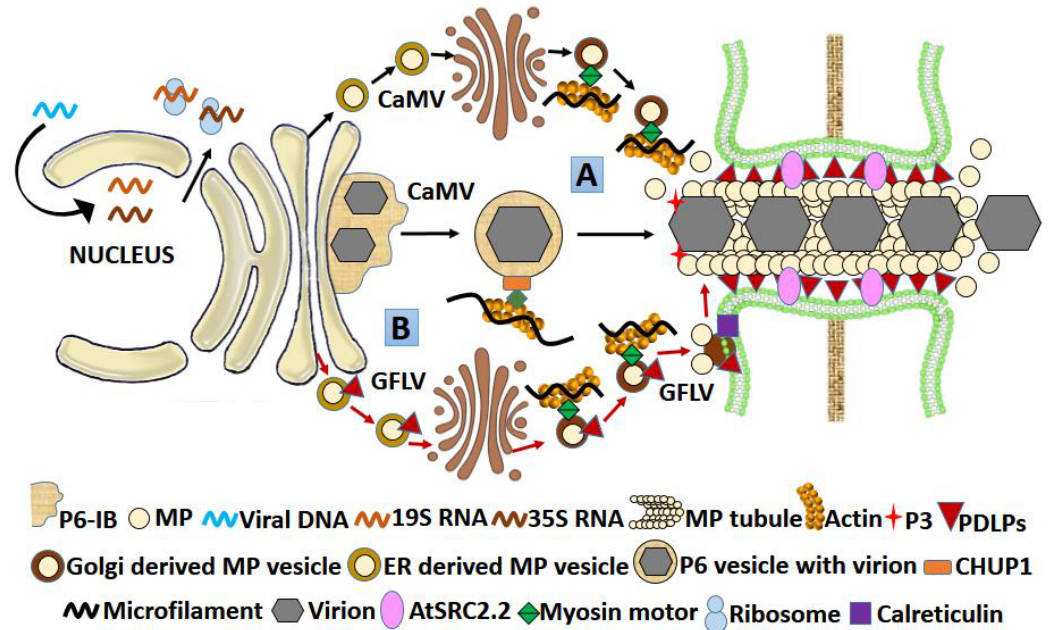
Figure 5. Model for tubule formation by MP in CaMV and GFLV (A) The CaMV vDNA transcribes in the nucleus to 19S and 35S RNA, which translate in the cytoplasm. The 19S RNA encodes a 58 kDa P6 protein that forms ribosomes rich IB (virus factory), the center for other virus proteins translation (e.g., P1-MP, P3, P4-CP, etc.) by 35S RNA. The MP reaches PD through vesicular transport via secretory pathway (black arrows), resulting in multiple MP copies that form tubule across PD. Once the virus attains a threshold copy number in IB, the P6 protein detaches as a vesicle and is assisted by CHUP1 to move over the actin filament network. After the virion reaches PD, the MP interacts with the virion (vDNA+56 kDa CP) through P3. PDLPs (also an MP receptor) and AtSRC2.2 at the PD help in the virion delivery. The virion delivery to the next cell putatively occurs through a tread-milling mechanism where there is unidirectional addition of vDNA-P3-CP-MP subunits assembly at one end and subsequent disassembly at the other, causing the virion delivery [7,137]. (B) The virion delivery is similar in GFLV, but here the MP first reaches the calreticulin-rich sites on the PM and thereafter, it reaches the PD by diffusion (red arrows). The PDLP is also delivered to PD by diffusion through PM, where it reaches via a secretory pathway in association with class XI, XI-K and XI-2 myosin [11,129]. Abbreviations: AtSRC2.2— Arabidopsis thaliana